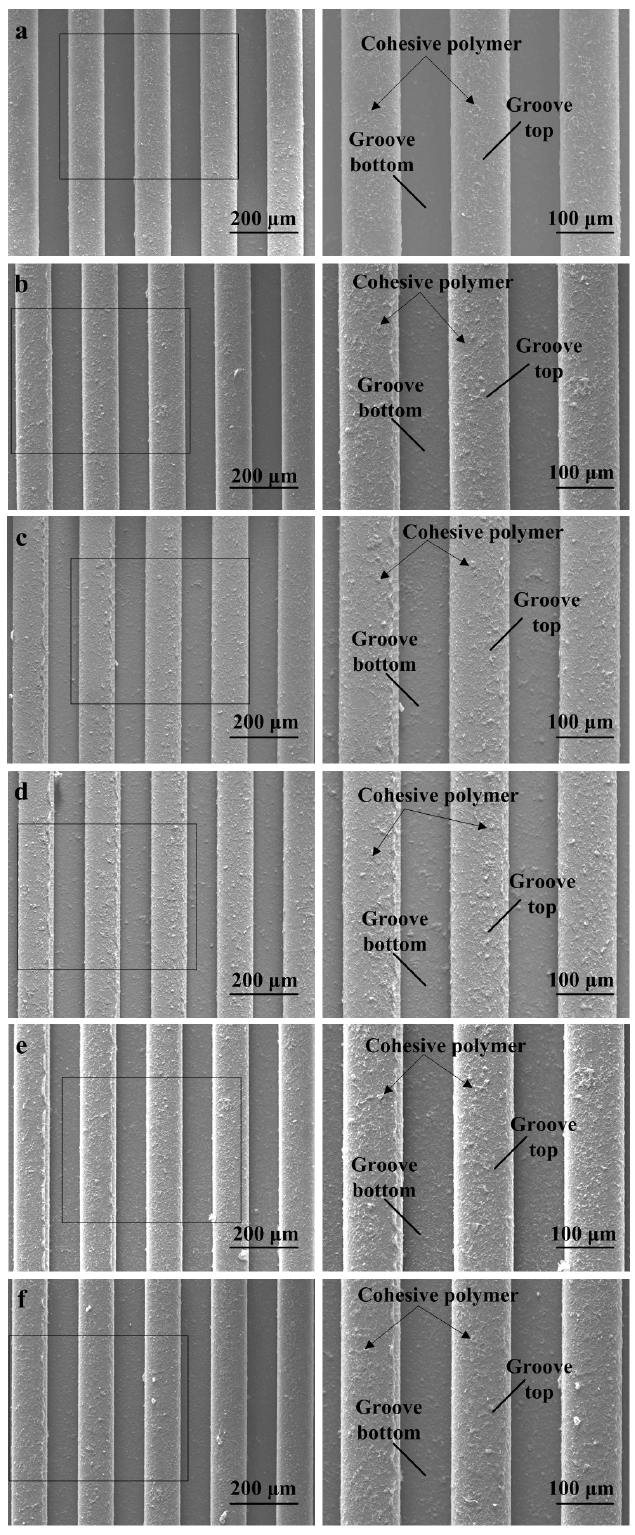
Figure 7. SEM photos of the selected micro-structured polymer samples: (a) Sample 3; (b) Sample 5; (c) Sample 6; (d) Sample 11; (e) Sample 17; (f) Sample 25.